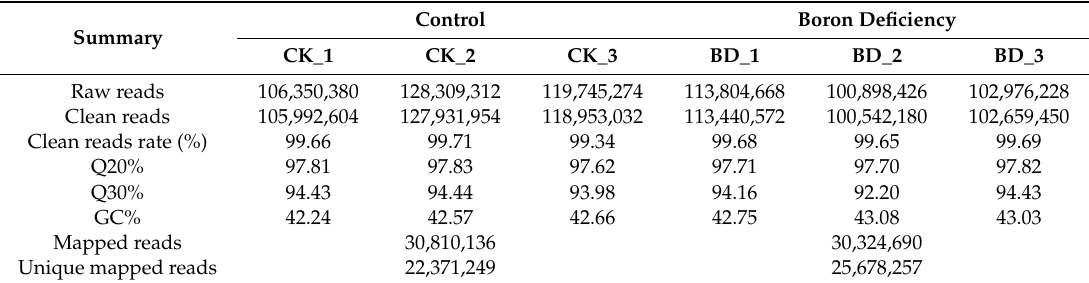
Table 1. Summary of the RNA-seq data for six samples.